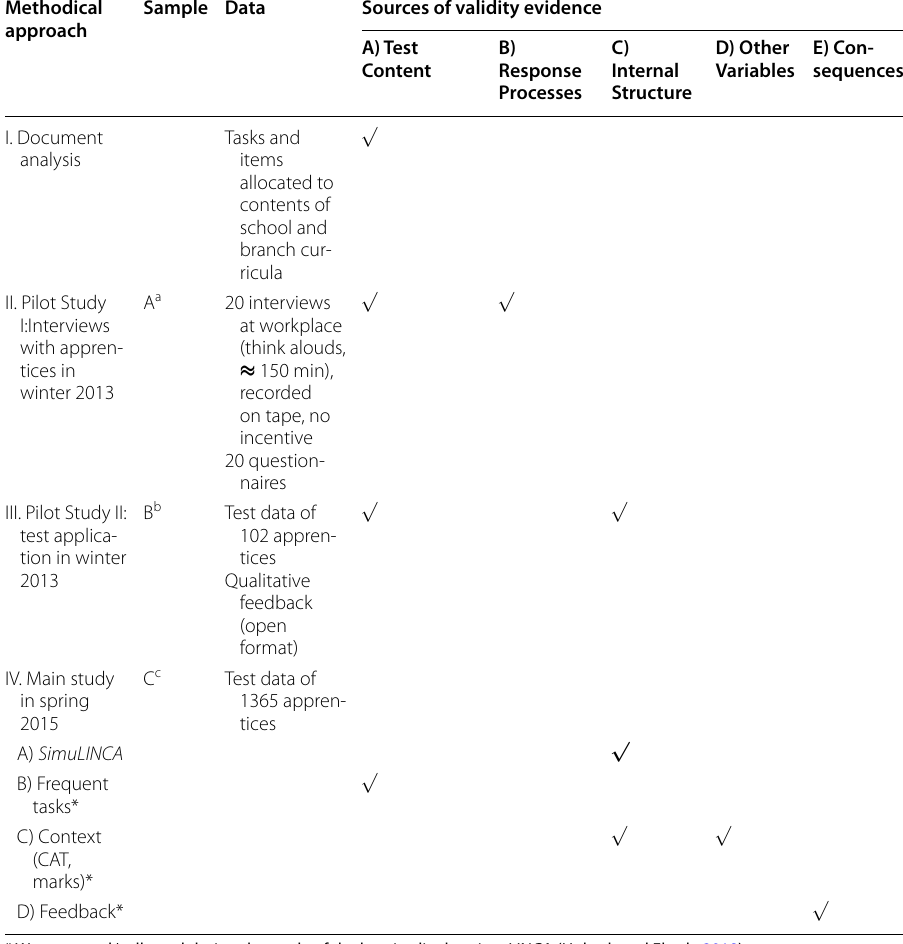
Table. 3 Methodical approach and sources of validity evidence for